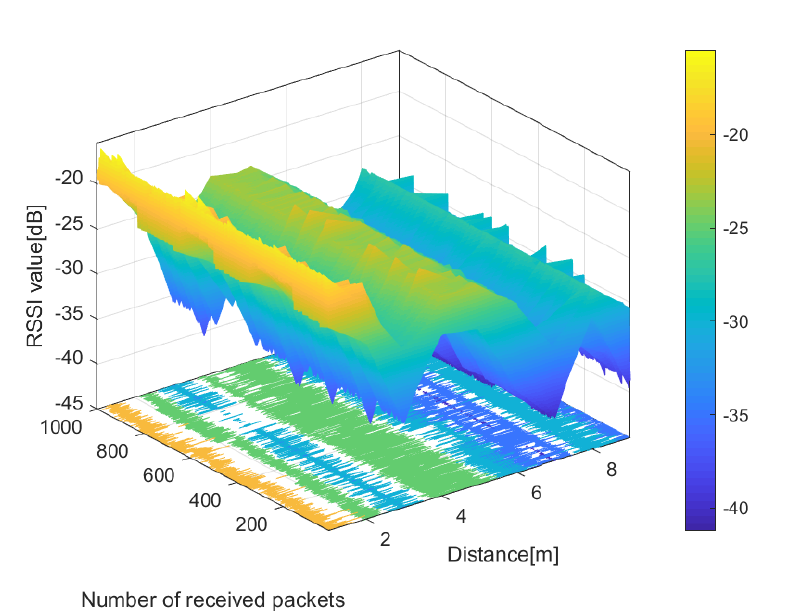
Figure 13. 3D graph of RSSI signal attenuation with distance in IT-1 building.